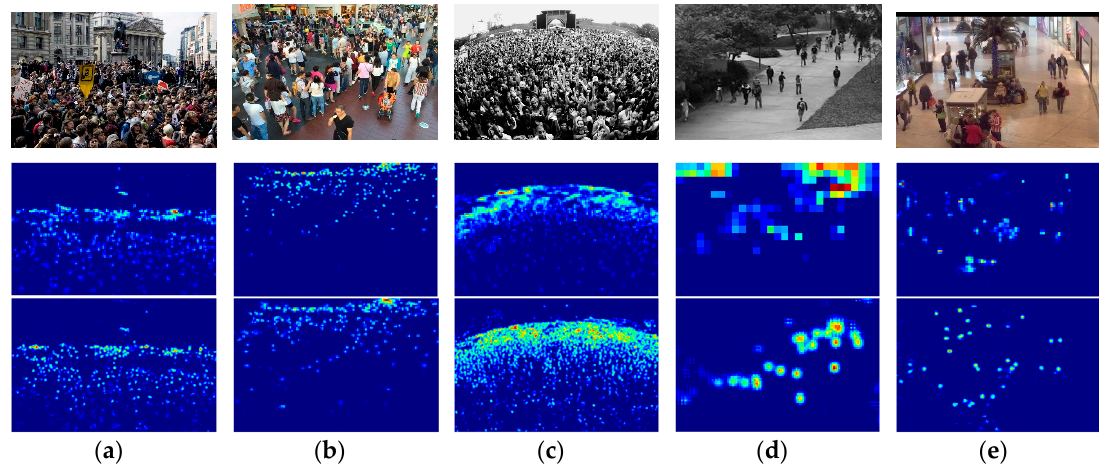
Figure 3. Some output density map of our FDCNet and the VGG-16 backbone. The first row are the original images in dataset, and the second row are the estimation density maps of the VGG-16 backbone. The third row are the estimation density maps of FDCNet. The images are selected from all datasets. They are selected from ( a ) ShanghaiTech Part A dataset; ( b ) ShanghaiTech Part B dataset;